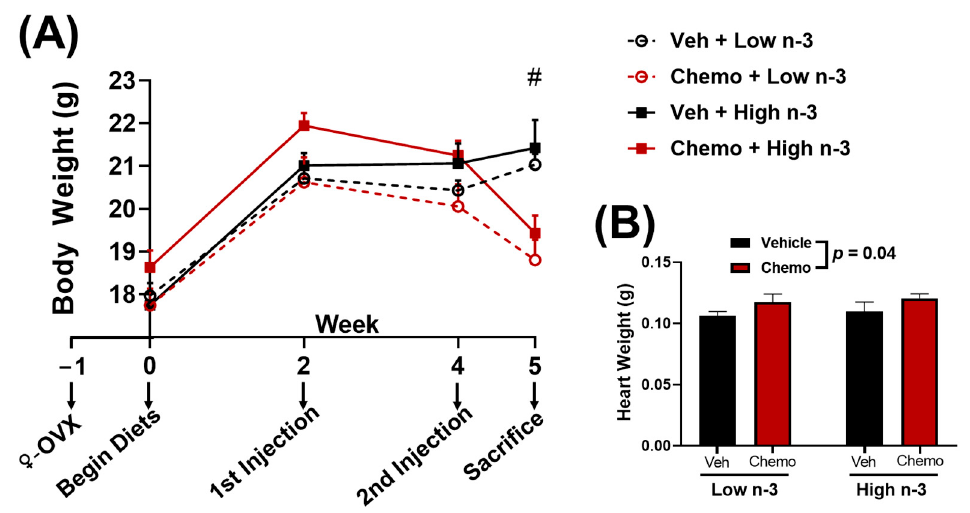
Figure 1. ( A ) Body weight and ( B ) heart weight between groups. Data presented as group means ± SEM ( n = 9/group). Two-way ANOVA was used to detect differences between groups. #— p < 0.05 difference between vehicle and chemo mice. Chemo—9 mg/kg anthracycline + 90 mg/kg cyclophosphamide injections; ♀ -OVX—female ovariectomy; Veh—saline vehicle injections; Low n-3—0 g/kg EPA + DHA diet; High n-3—12.2 g/kg EPA + DHA diet (~2% kcal). Mice were individually housed in a vivarium with room temperature of 22 ± 0.5 °C